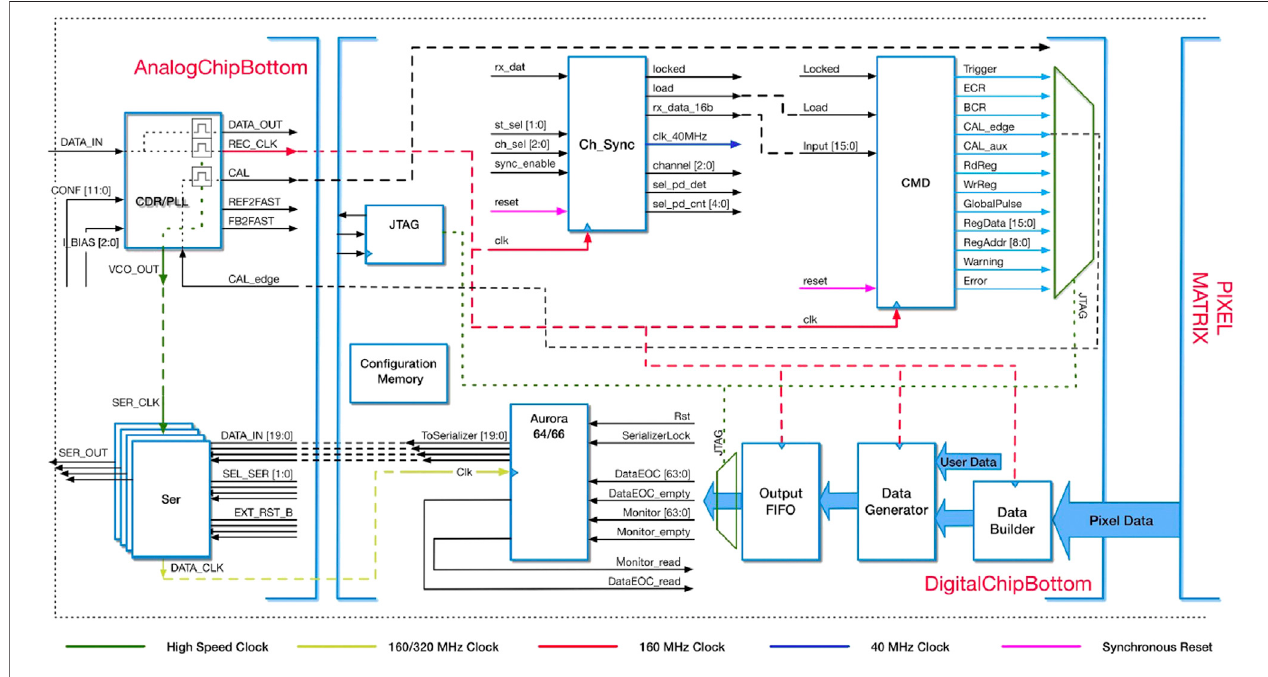
FIGURE 9 | Schematics of digital RD53A periphery and connection to I/O From [16].